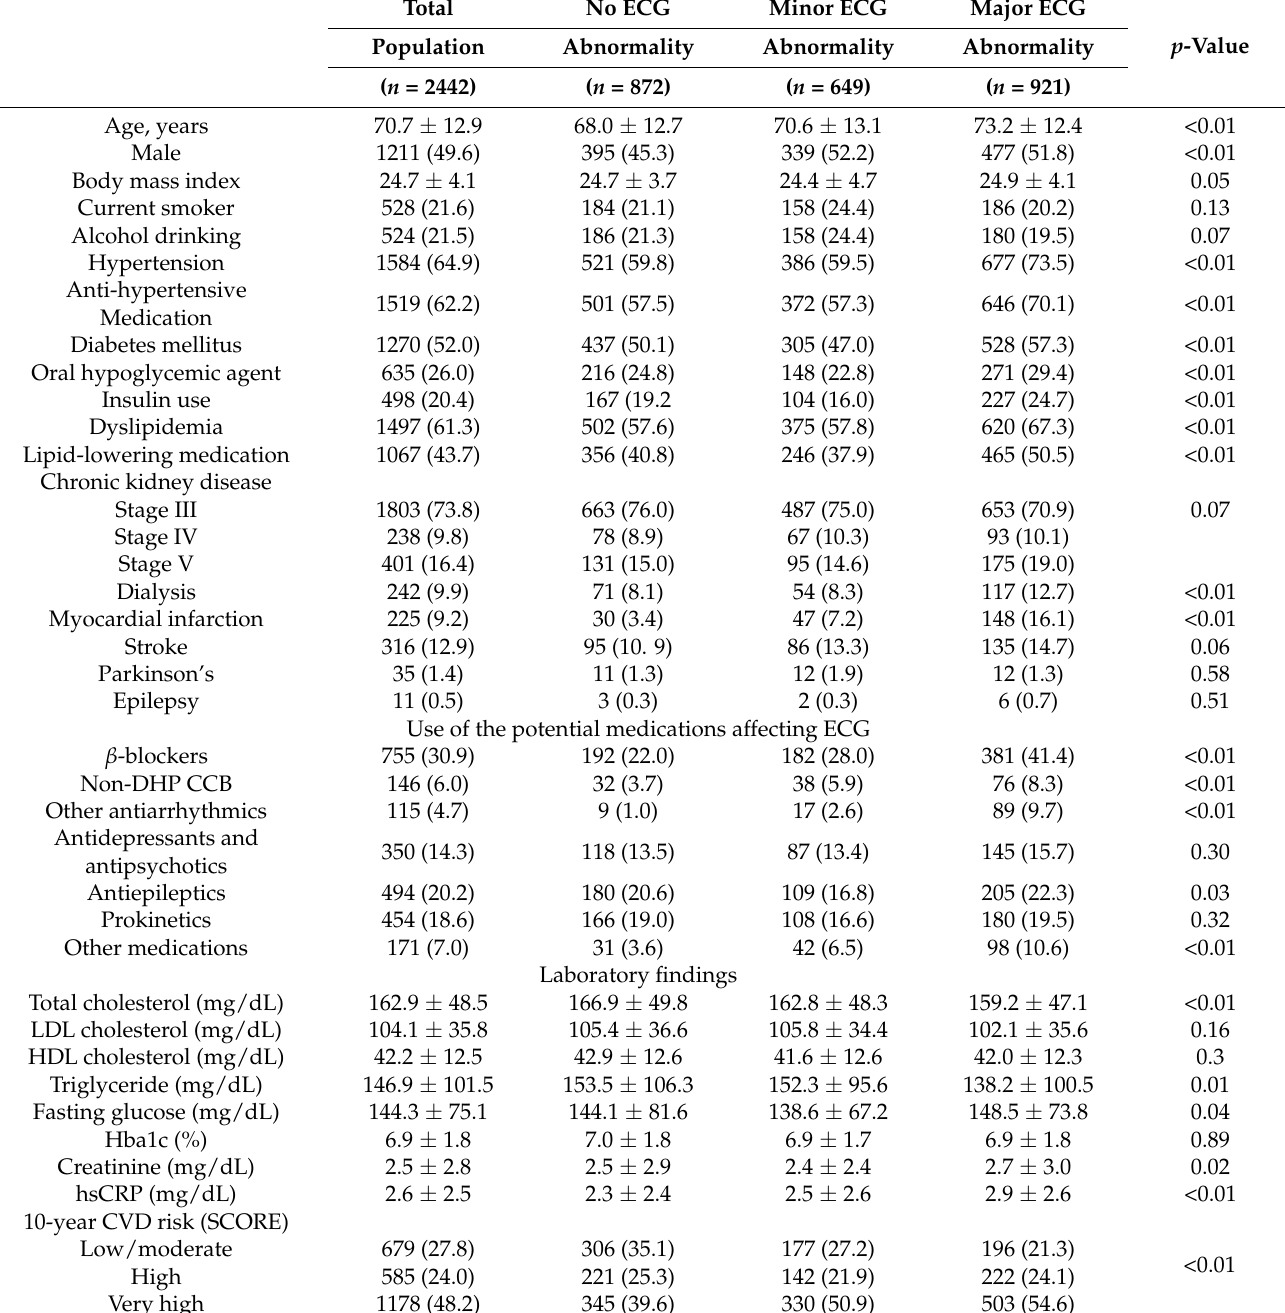
Table 1. Baseline characteristics of study groups according to ECG